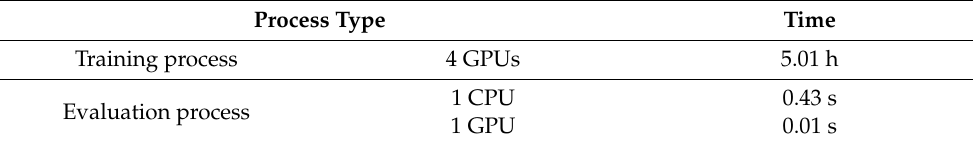
Table 8. Time consumption of the training and the evaluation process.